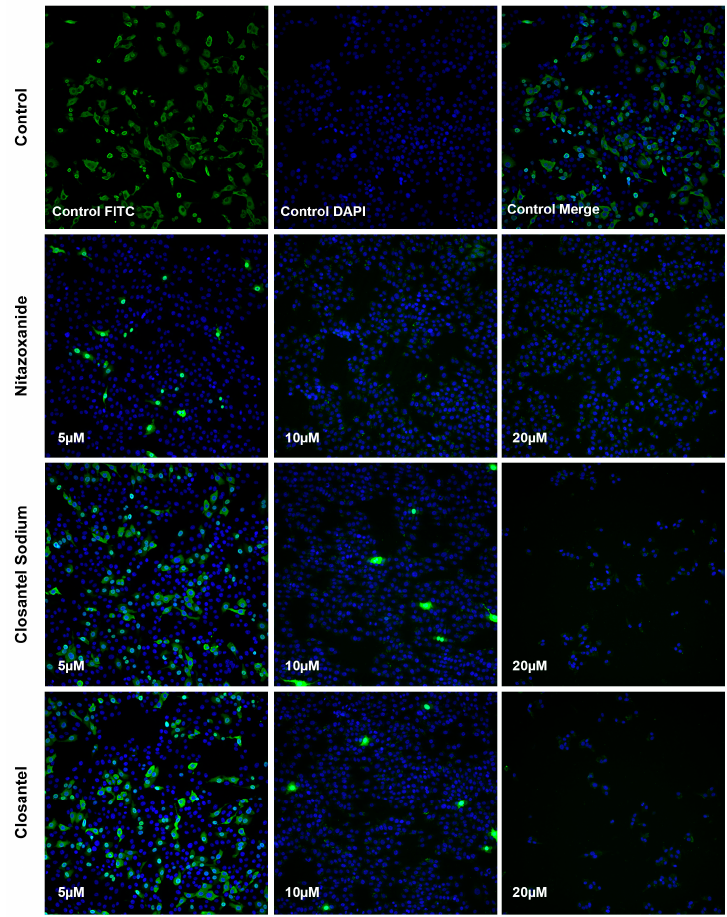
Figure 4. The antiviral effects of identified drugs were analysed via IFA. F81 cells were treated with 0.1% DMSO (Control) or 5 µ M, 10 µ M, or 20 µ M of Nitazoxanide, Closantel Sodium, or Closantel before CPV infection. Then cells were fixed with 80% acetone at about 30 hpi and immunostained for VP2 protein (green), while nuclei (blue) were stained with DAPI.